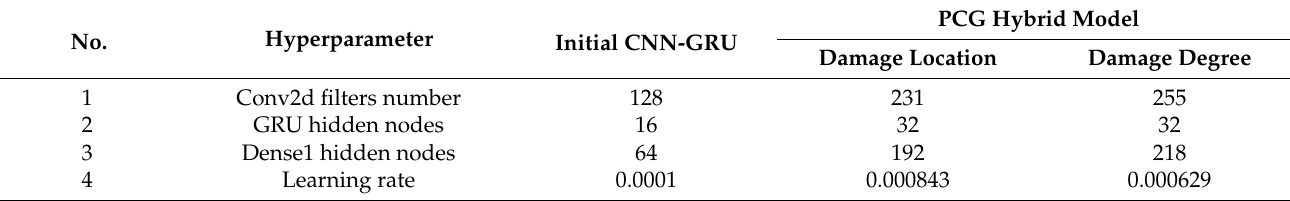
Table 6. Hyperparameters comparison of initial CNN-GRU and